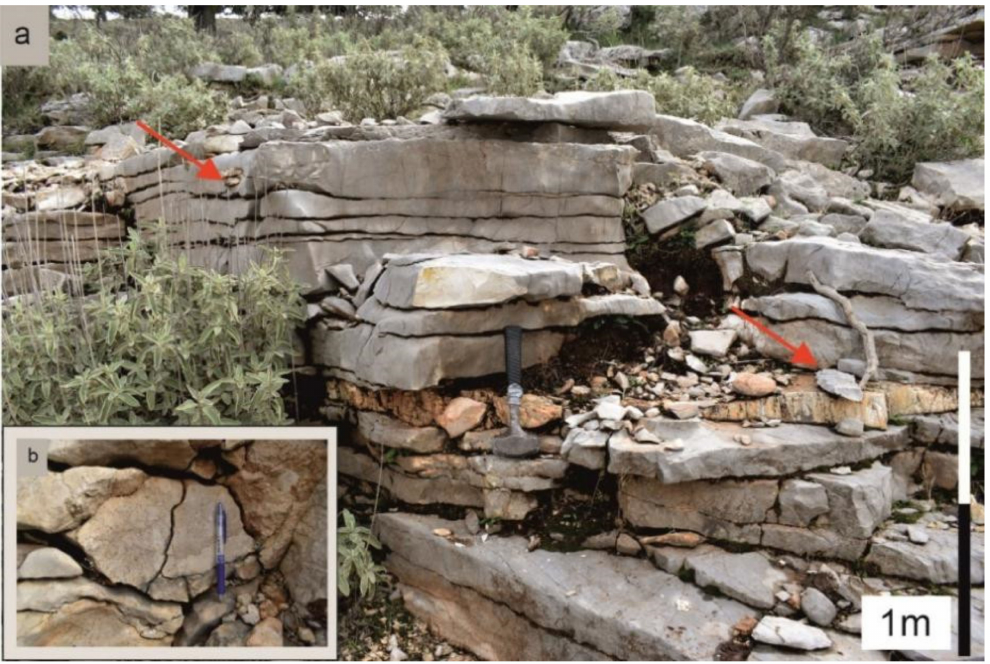
Figure 10. ( a ) General view of the outcrop of the Paleocene micritic limestones where nodules and thin layers of chert (red arrow) locally occur, ( b ) closer view of a Microbreccia limestone.